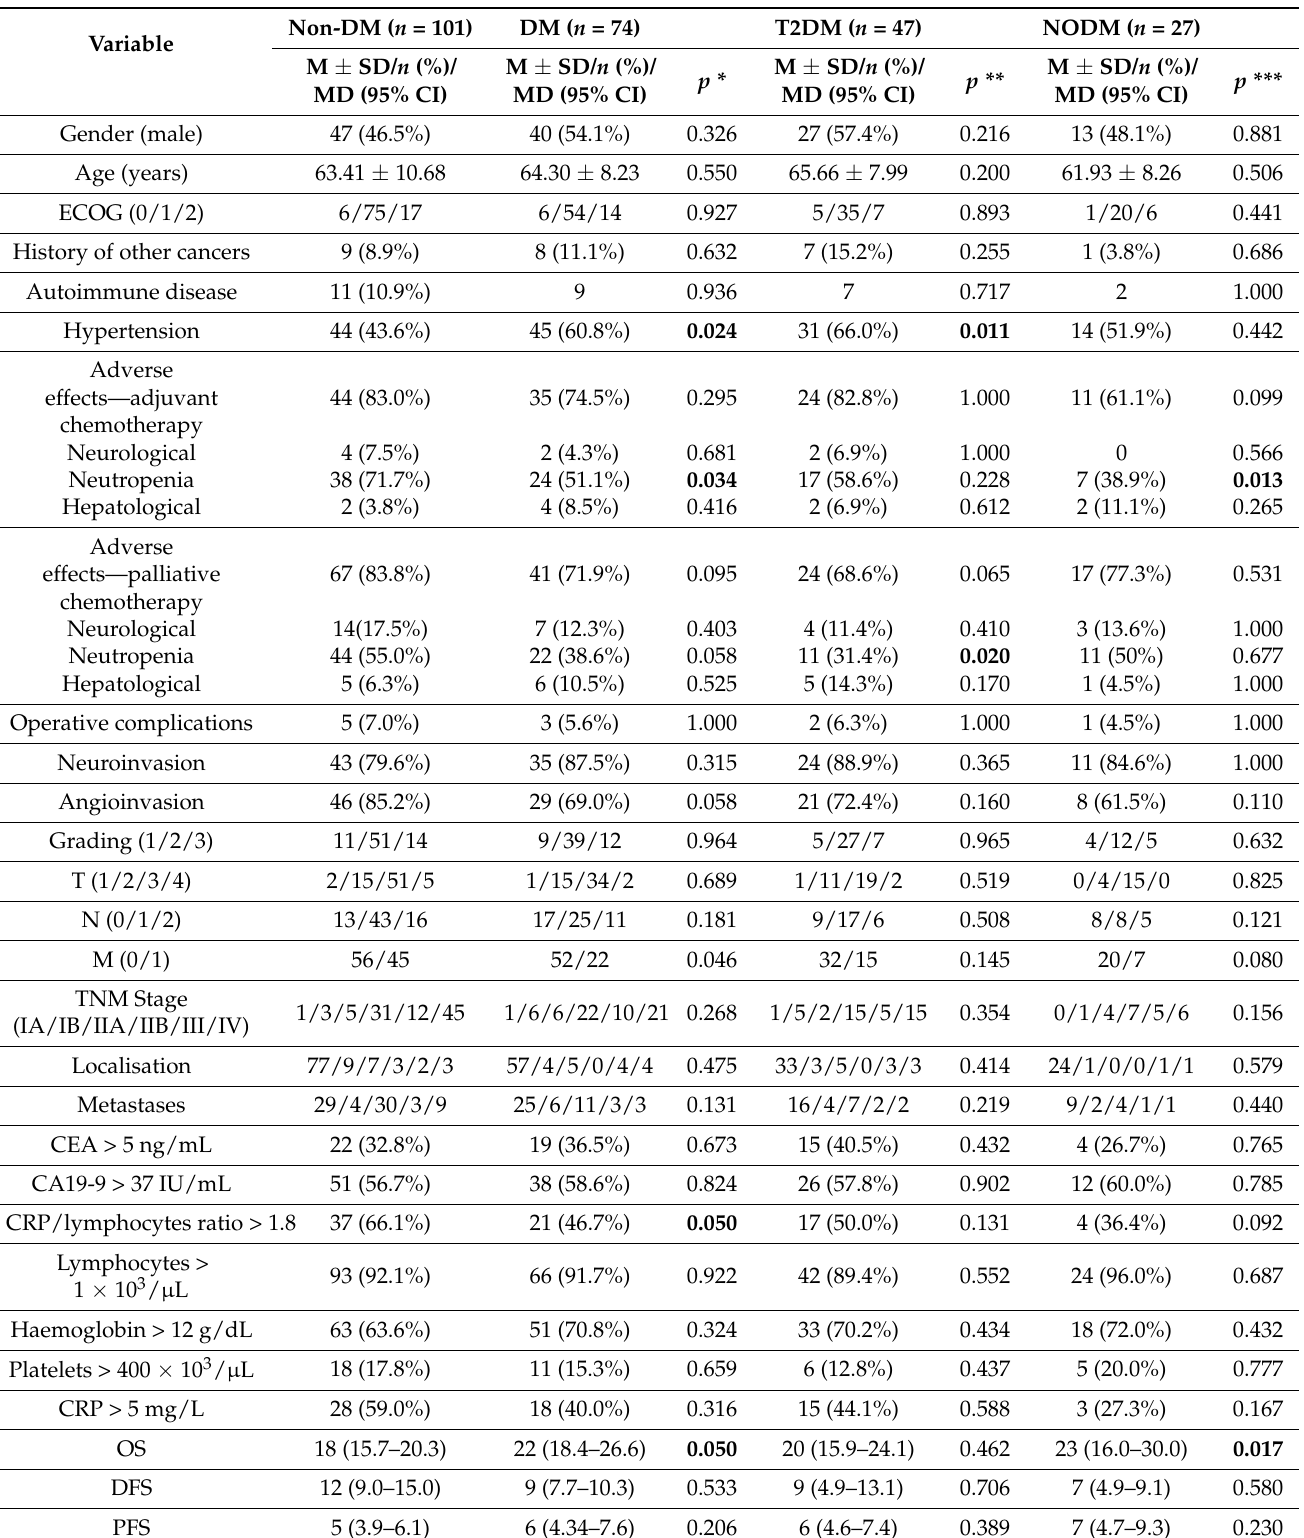
Table 1. Characteristics of the three study groups and comparison to the non-DM